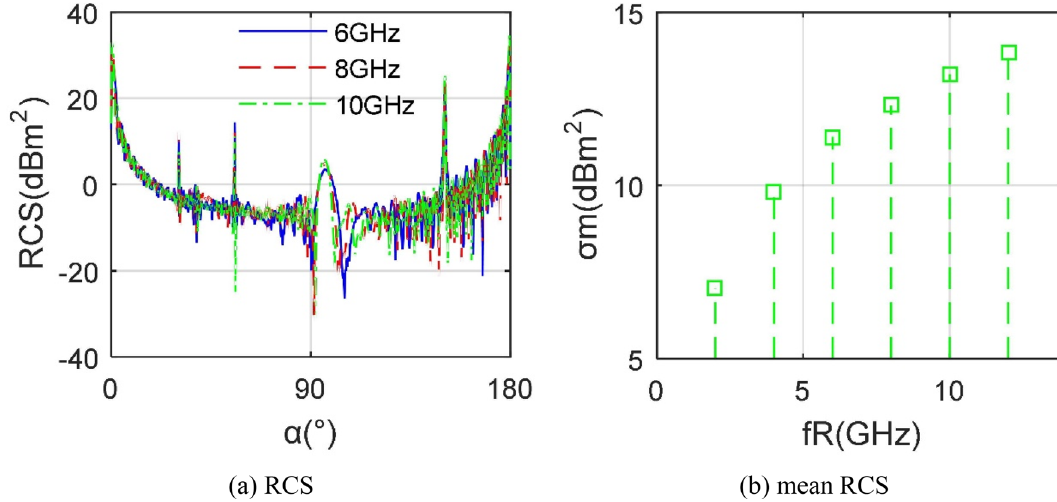
Figure 9. RCS of aircraft model under different radar wave frequencies, β = 0°.